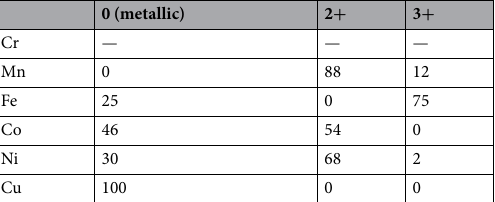
Table 1. The XPS spectra in Fig. 3 were decomposed into their component oxidation states through a linear combination of common oxides and metals. The tabulated values in this table indicate the percentage of each oxidation state found for each dopant metal on the Bi 2 Te 3 surface. The corresponding linear sum is also plotted in Fig. 3 as grey